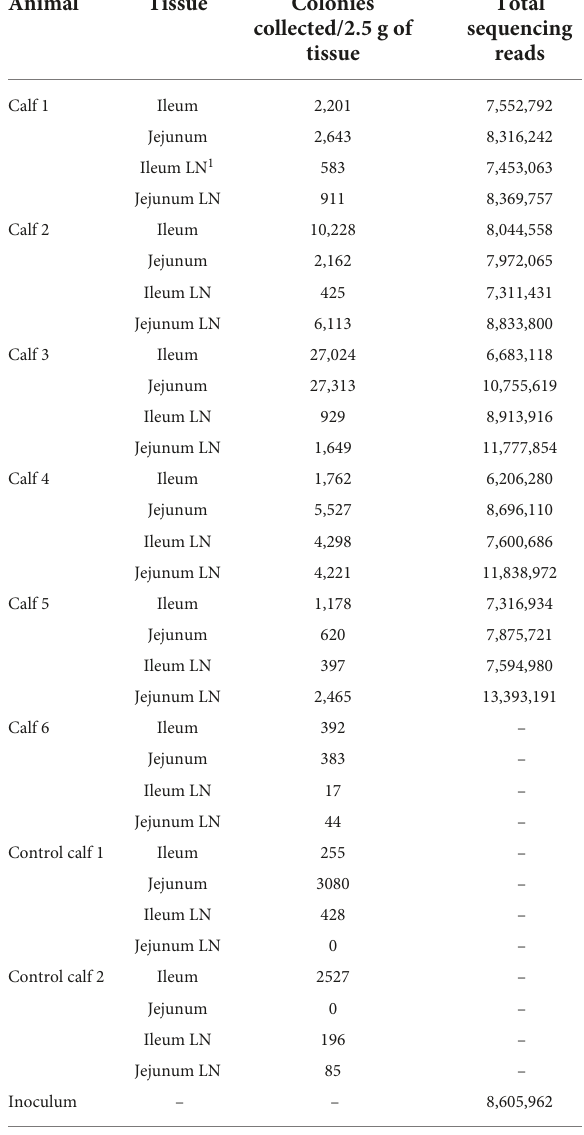
TABLE 1 CFUs collected from all calf tissues and sum of reads per tissue from the targeted next-generation sequencing.